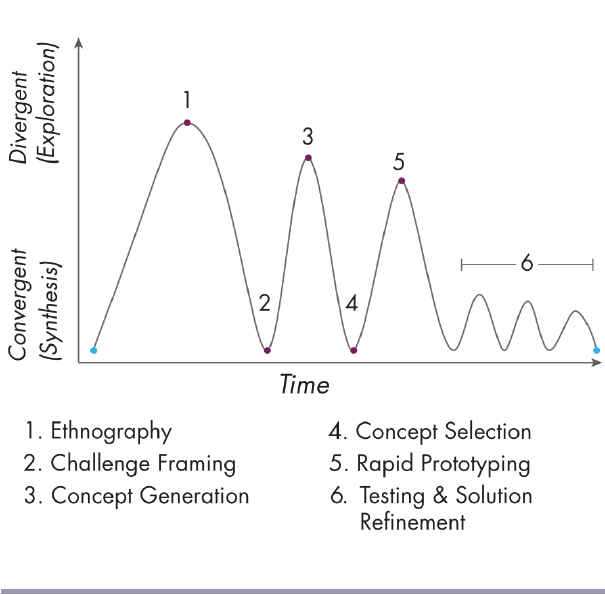
Fig. 1 . The convergent (synthesizing insights) and